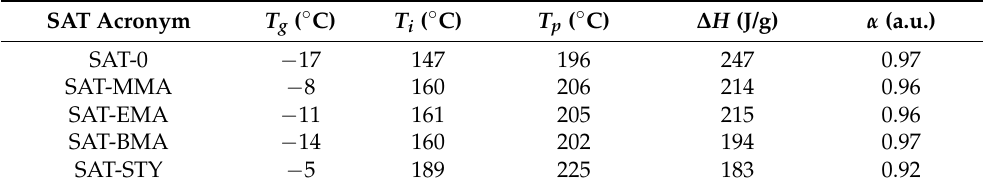
Figure 6. DSC thermographs of the UV-crosslinked SATs ( a ) and SATs after UV-crosslinking and thermal curing ( b ). Table 5. Thermal features of UV-crosslinked SATs (UV dose of 3 J/cm 2 ) and cross-linking degree of thermally cured SATs.